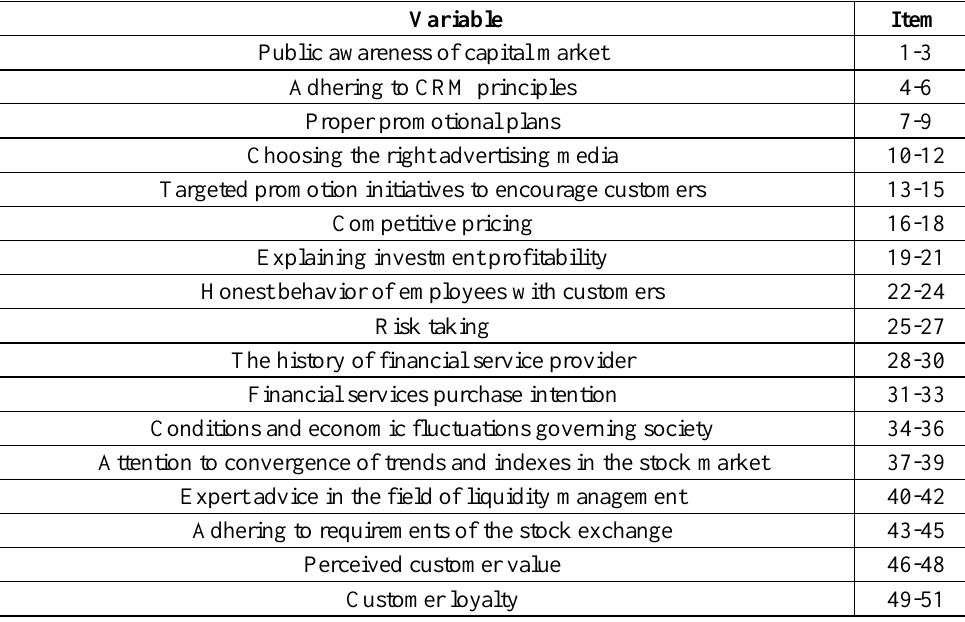
Table 1. Structure of the questionnaire in the quantitative phase